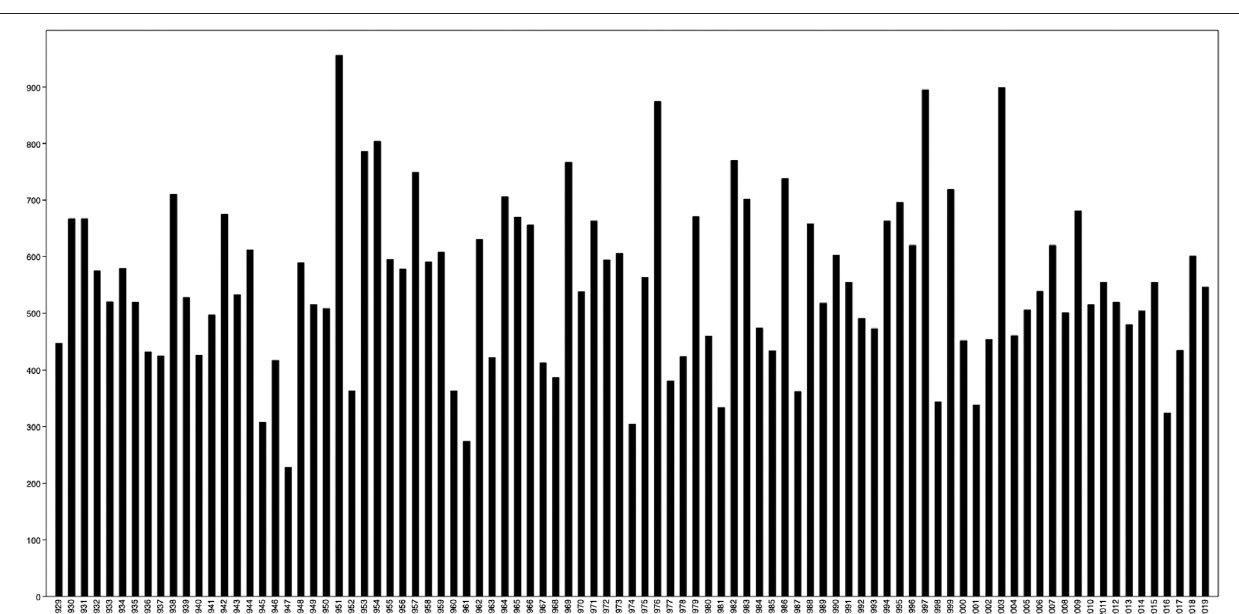
FIGURE 5 | Annual rainfall (mm) in Malta, 1929 – 2019 (Data provided by the National Meteorological Of fi ce, Malta International Airport).